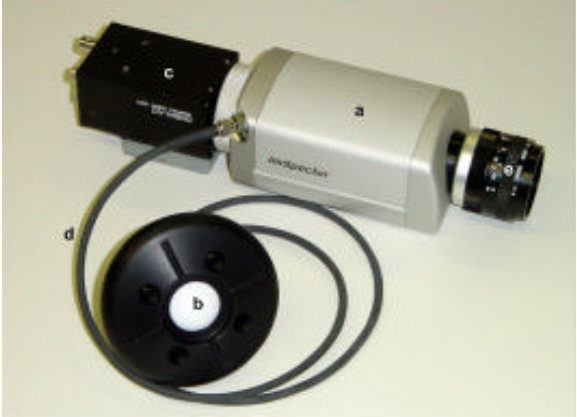
Figure 2. Imaging Spectrograph ImSpector V9 (a); diffuse collector of incident light - Phodis (b); CCD-sensor PCO PixelFly; Optic cable (d); Objective lens Schneider-Kreuznach f=24mm (e) (Baji ć et al., 2004)